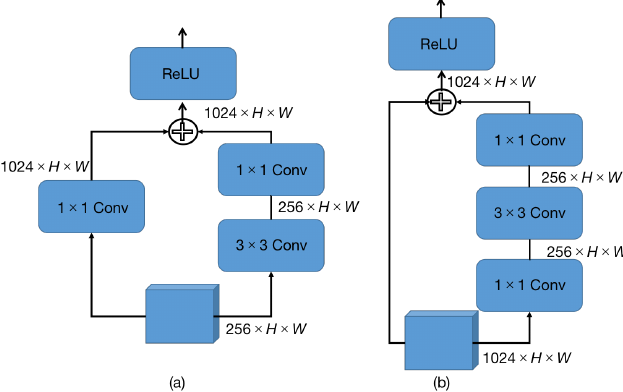
Figure 8. ( a , b ) Schematic of two different kinds of resblocks in conv-head.